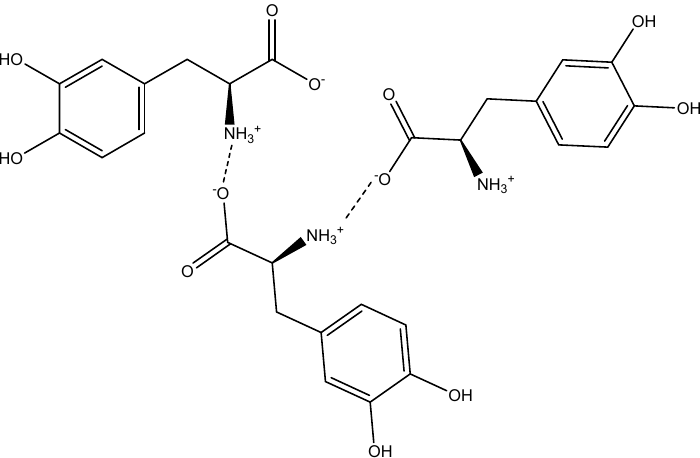
Figure 3. Example of the potential l -DOPA intermolecular network formed during extraction t a neutral pH.